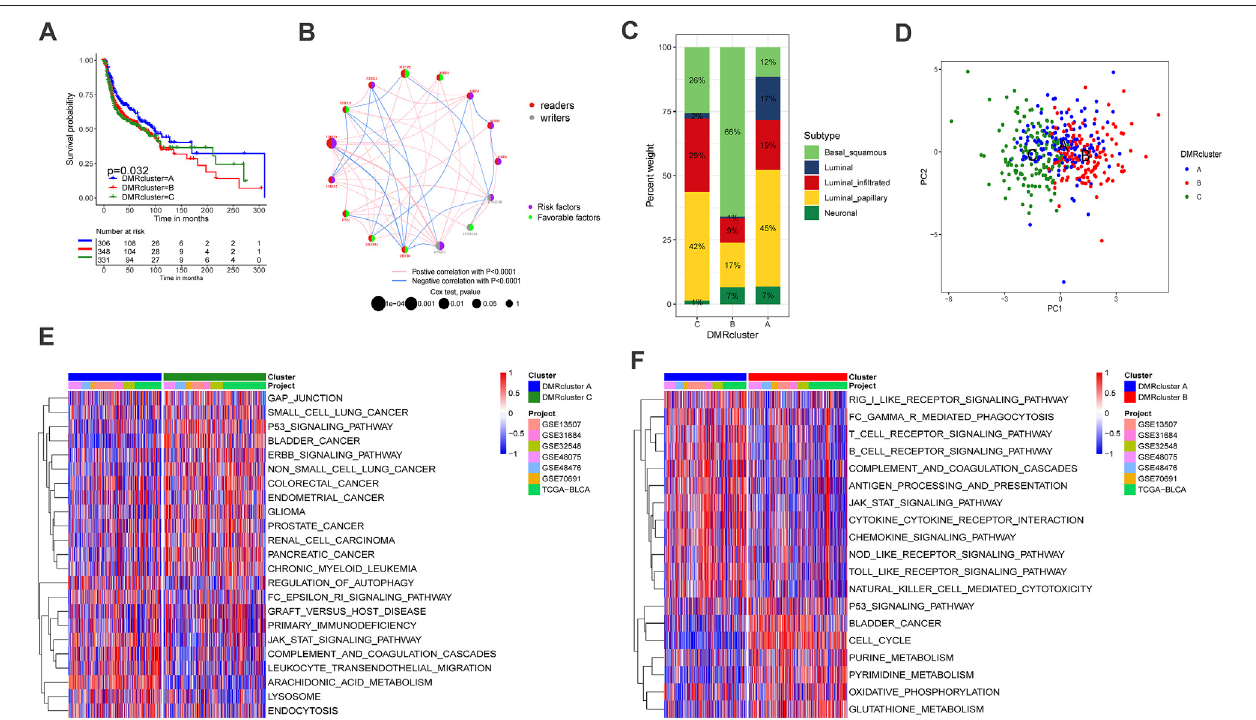
FIGURE 2 | Clusters ofDNA methylation modes and biological pro fi les of each cluster. A Kaplan-Meier curve with p value 0.032 displayed a remarkable difference among three DNA methylation modes, the DMRcluster B presented a remarkable poor clinical outcome. DMRcluster (A) : 306 samples, DMRcluster (B) : 348 samples and DMRcluster (C) : 331 samples. The meta cohort including 985 samples (GSE13507, GSE31684, GSE32548, GSE48075, GSE48476, GSE80691 and TCGA- BLCA). (B) The interplay among DNA methylation regulators in bladder cancer. Red and gary represented readers and writers respectively. The size of circles displayed the in fl uence of each regulator on clinical outcomes. The lines connecting regulators represented their interactions, and thickness represented the correlation strength. Negative correlation was labeled with blue and positive correlation was labeled with red. Risk factor: purple, favorable factor: green. (C) The proportion of molecularsubtypes inthethreeDNAmethylationmodes (TCGA-BLCA). Basalsquamous subtype, green; Luminal subtype, blue; luminalin fi ltratedsubtype, red; luminal papillary subtype, yellow; and Neuronal subtype, olivedrab. (D) Principal component analysis (PCA) for the transcriptome characteristics of three DMRclusters. DMRcluster A was labeled with blue color, DMRcluster (B) was labeled with red color and DMRcluster (C) was labeled with green. (E,F) Gene set variant analysis displayed the activation status of biological pathways in diverse DMRclusters. The heatmap help us to observe the difference of biology pathway activity among three DMRclusters. Blue represented inhibited pathways and red represented activated pathway. (E) DMRcluster (A) vs. DMRcluster (B) ; F DMRcluster (B) vs. DMRcluster (C) .